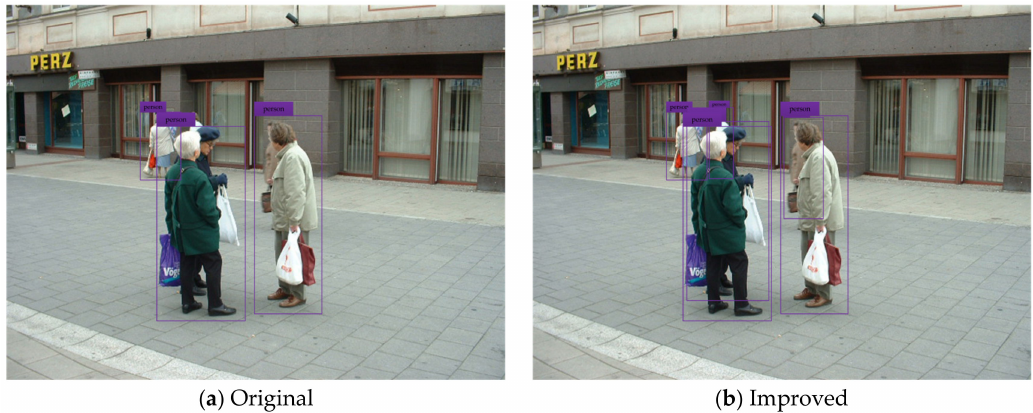
Figure 5. Pedestrian detection test results in the dim scenario.